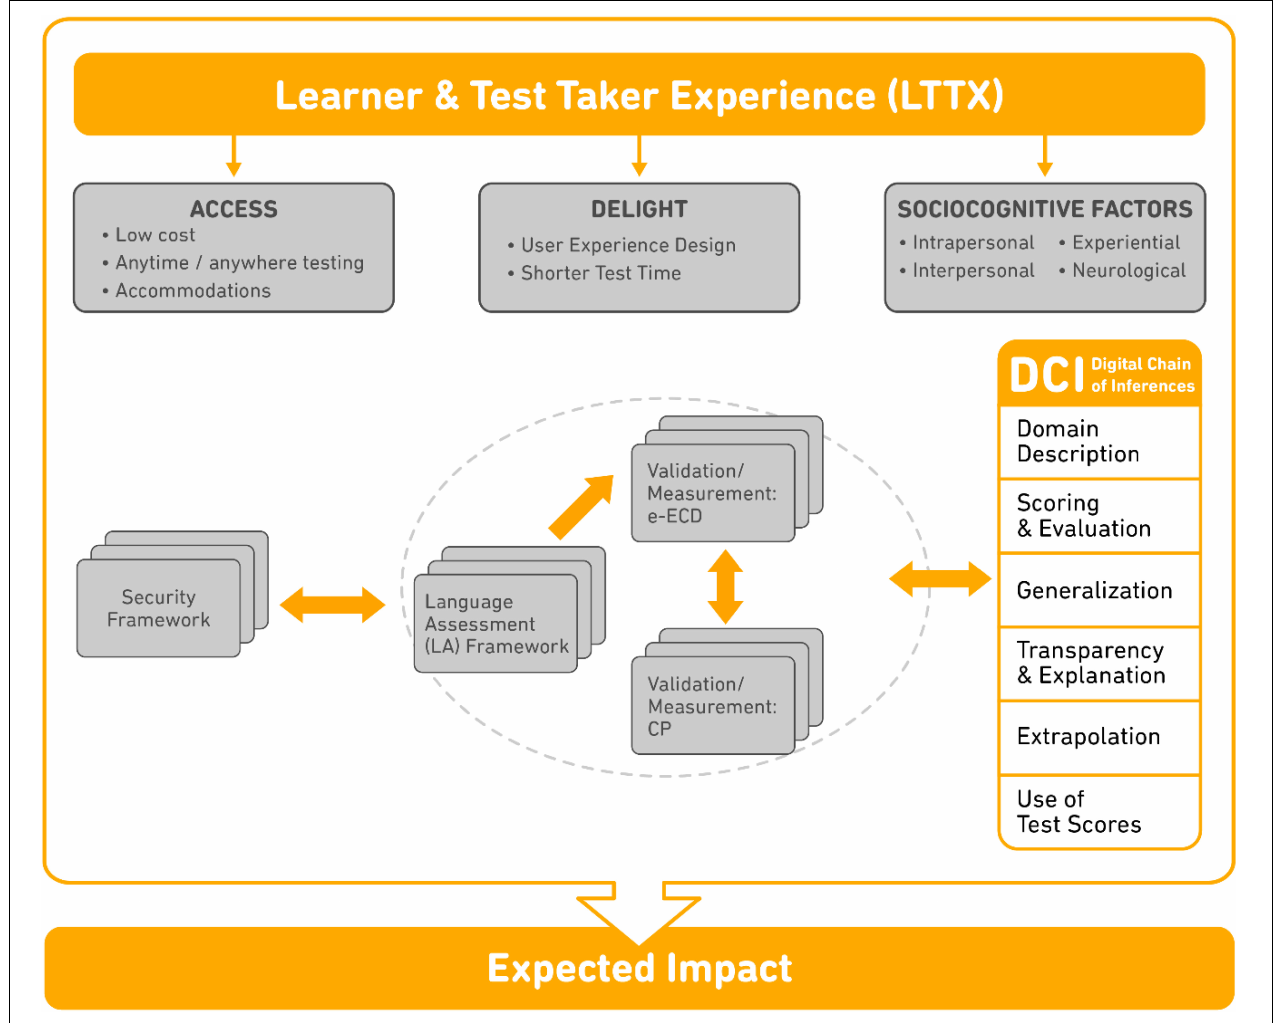
FIGURE 1 | Illustration of the digital-first ecosystem components and their interactions for an LAS. This figure is an expansion of Figure 1 from Burstein et al. (2022). The security framework and the LTTX influence all ecosystem components and together they provide support for achieving the Expected Impact, that is the democratization and equitability of education as